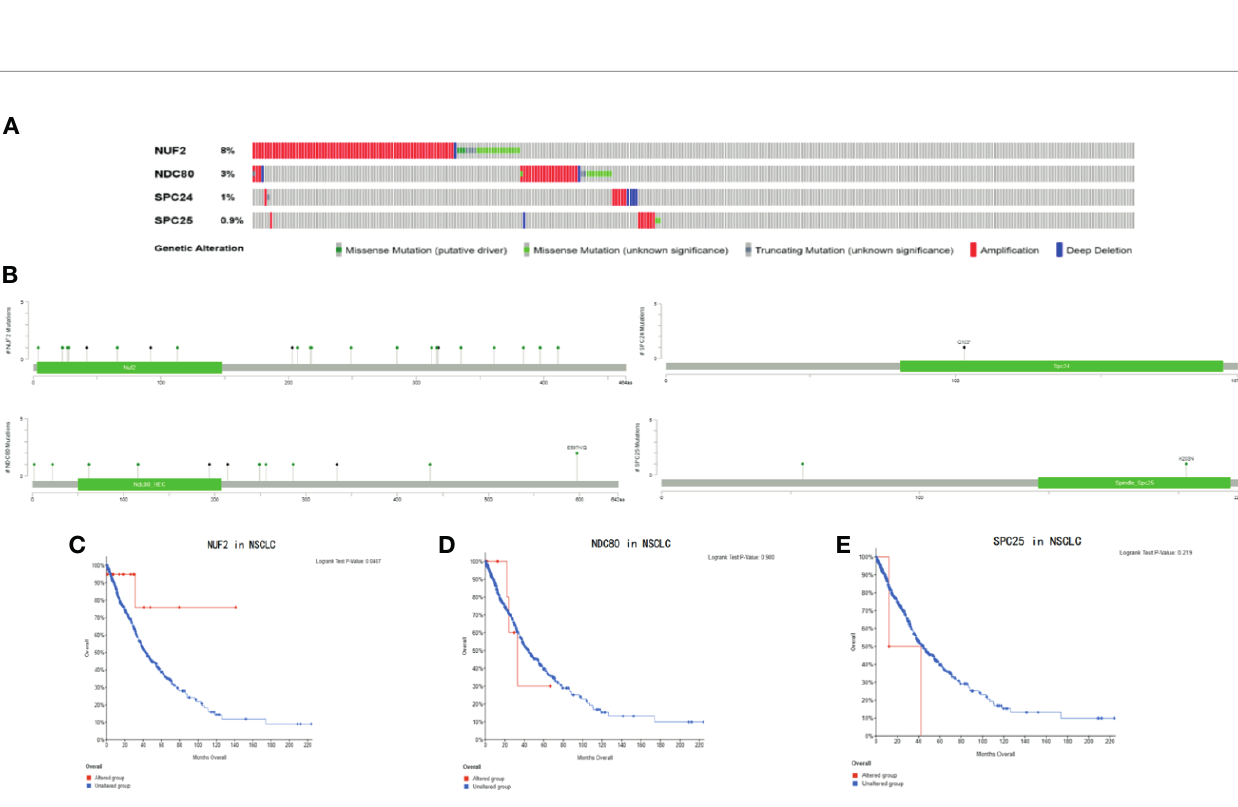
FIGURE 8 | (A) The types and frequency of gene alterations of NUF2, NDC80, SPC24 and SPC25 gene. (B) Detailed mutation type of NUF2, NDC80, SPC24 and SPC25 gene in subtypes of NSCLC. (C – E) Kaplan-Meier survival curve comparing the OS time of NUF2, NDC80, SPC24 and SPC25 gene for different gene alteration subgroups in